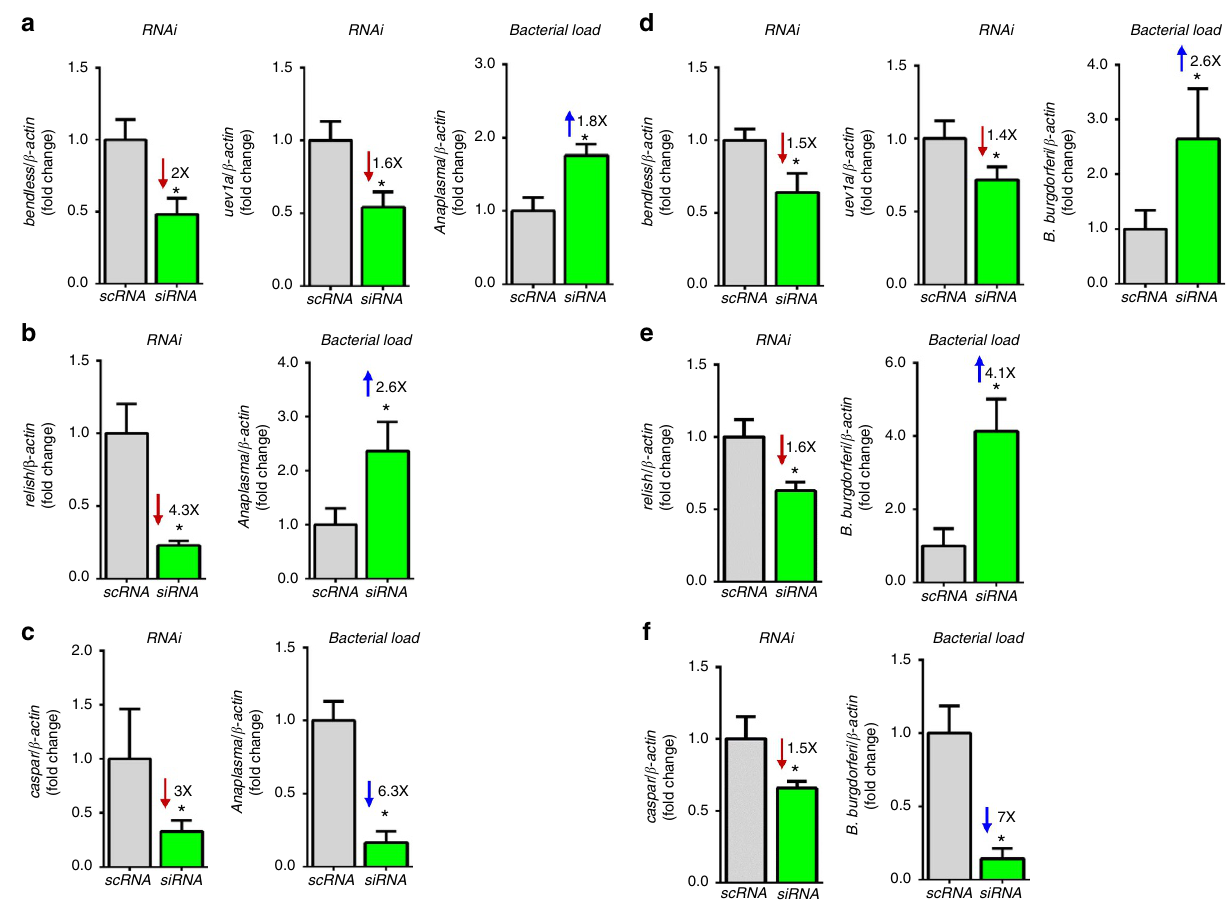
Figure 4 | The I. scapularis IMD pathway affects bacterial colonization in vivo . ( a ) RNAi silencing of bendless / uev1a, relish and caspar in I. scapularis nymphs following tick feeding on ( a – c ) A. phagocytophilum -infected or ( d – f ) B. burgdorferi -infected mice. Silencing levels and bacterial load were measured six days post-infection in whole I. scapularis nymphs. Samples represent the mean of 5–10 individual ticks, two technical replicates each, ± standard errors of the means (SEM). Student’s t test. * P o 0.05. scRNA, scrambled RNA; siRNA, small interference RNA. See also Supplementary Table post-stimulation of the I. scapularis tick cell line ISE6 (Fig. 5f,